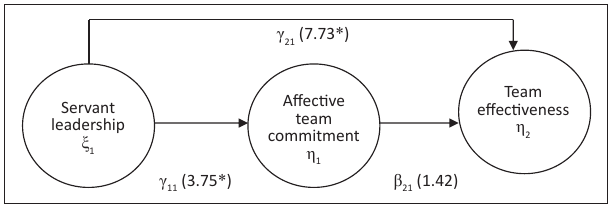
FIGURE 1: The conceptual structural